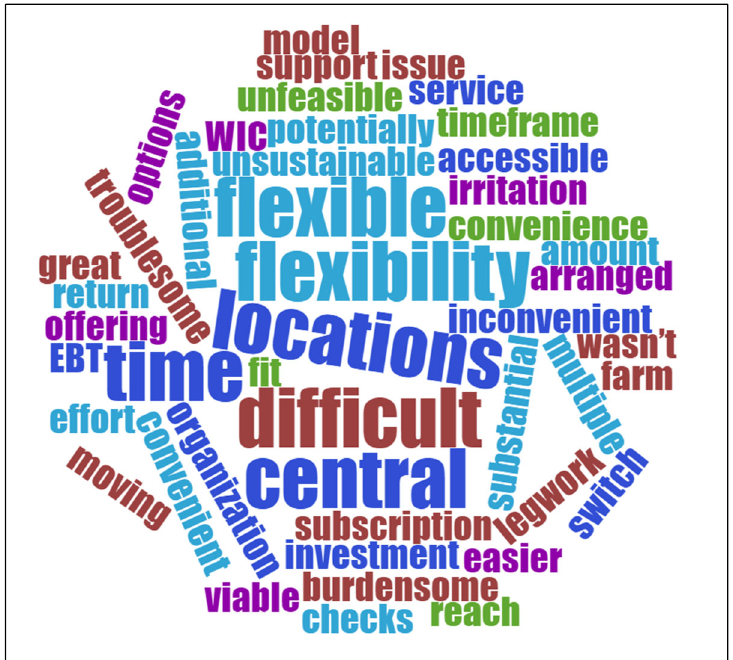
Figure 4. Word Cloud Summary of Farmer